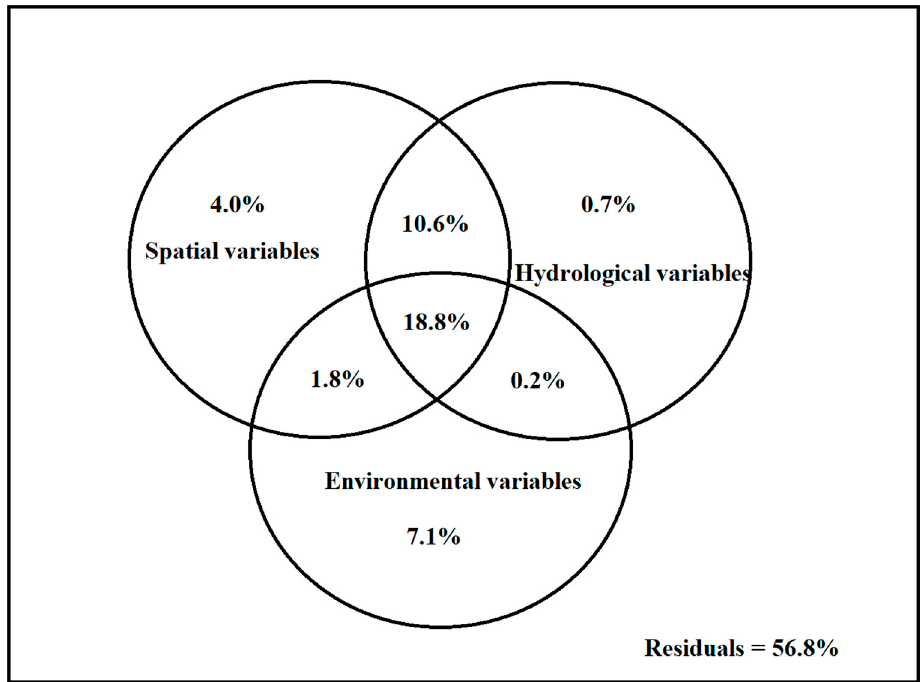
Figure 3. Contributions of the environmental, hydrological, and spatial variables to the variance in species composition in upstream of Lijiang River.